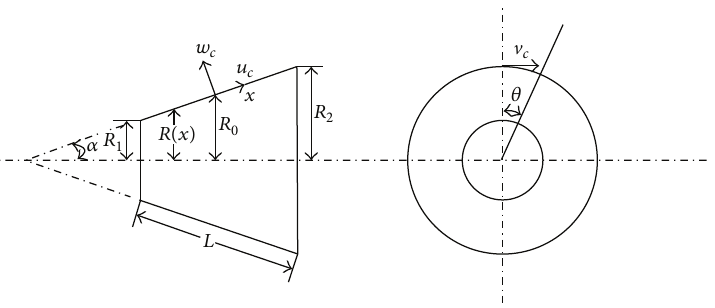
Figure 1: Coordinate system and displacements for a thin conical